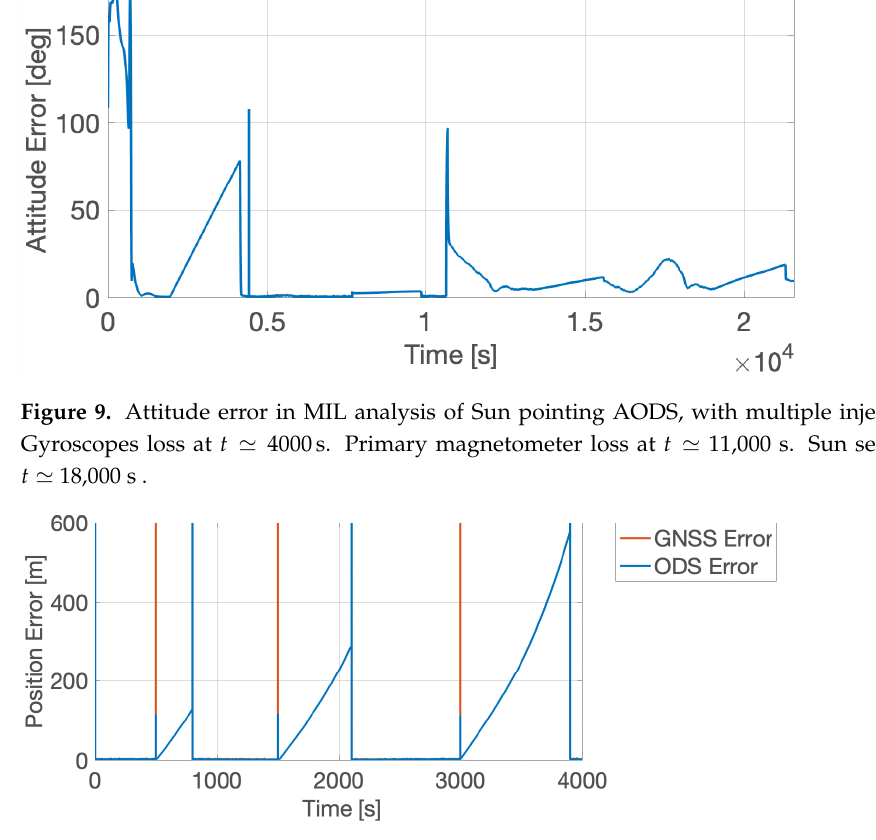
Figure 10. Position error in MIL analysis of ODS, with multiple GNSS outage periods: 5min at t (cid:39) 500s, 10min at t (cid:39) 1500s, and 15min at t (cid:39)